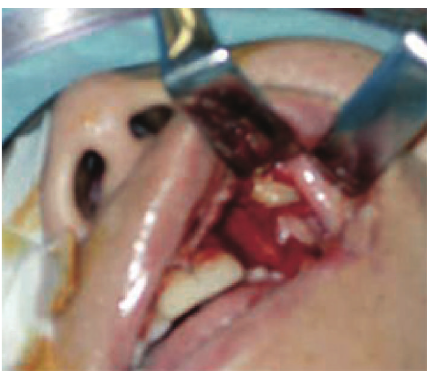
Figure 6: Intraoral view during operation showing exposure of embedded canine into soft tissue of the vestibule of the mouth.